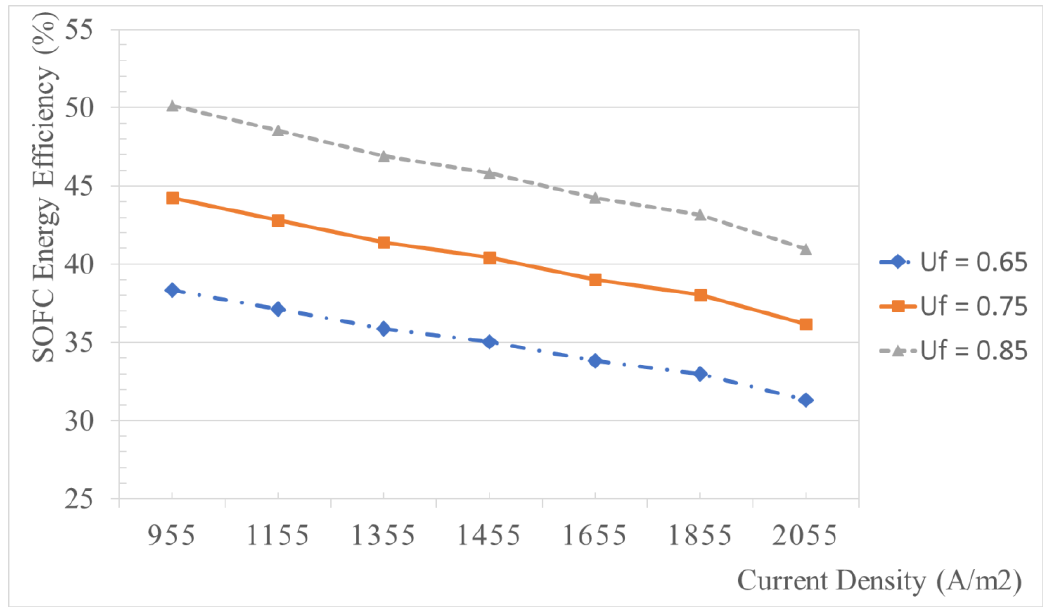
Figure 8. Effect of fuel utilization factor on the SOFC energy efficiency.